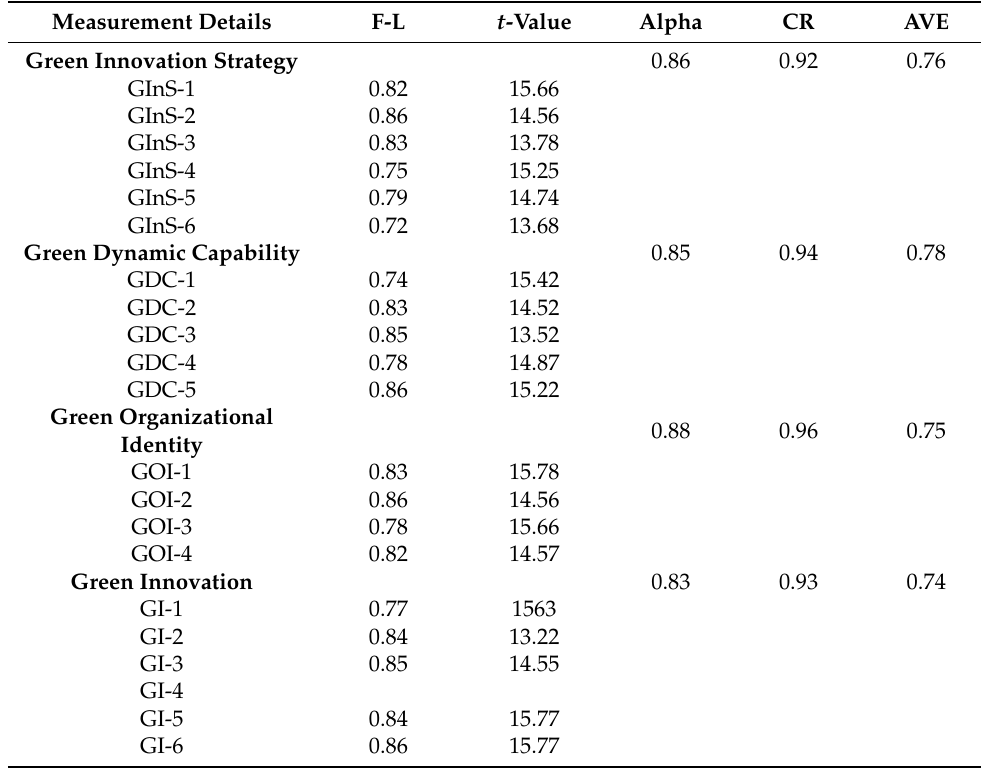
Table 2. Results of FactorLoading, Cronbach Alpha, CR, AV.